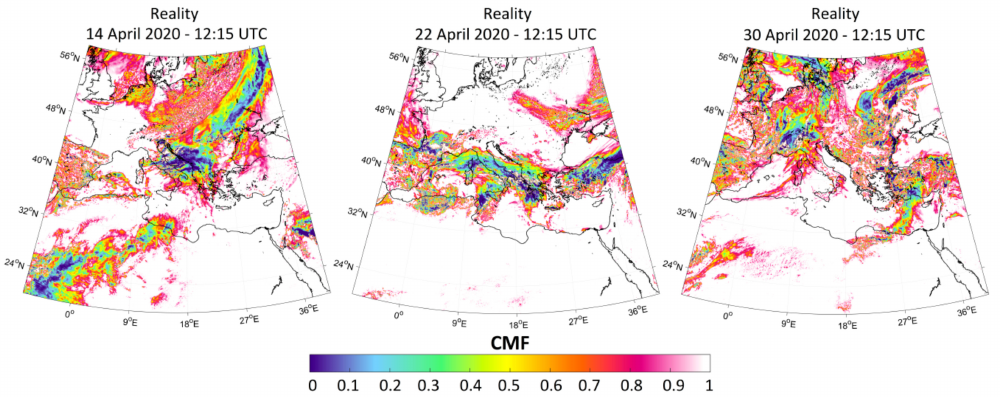
Figure 1. The cloud modification factor (CMF) for 14, 22 and 30 April 2020 at 12:15 UTC, as calculated by the fast radiative transfer models (FRTM) using as input the Meteosat second generation (MSG) cloud optical thickness